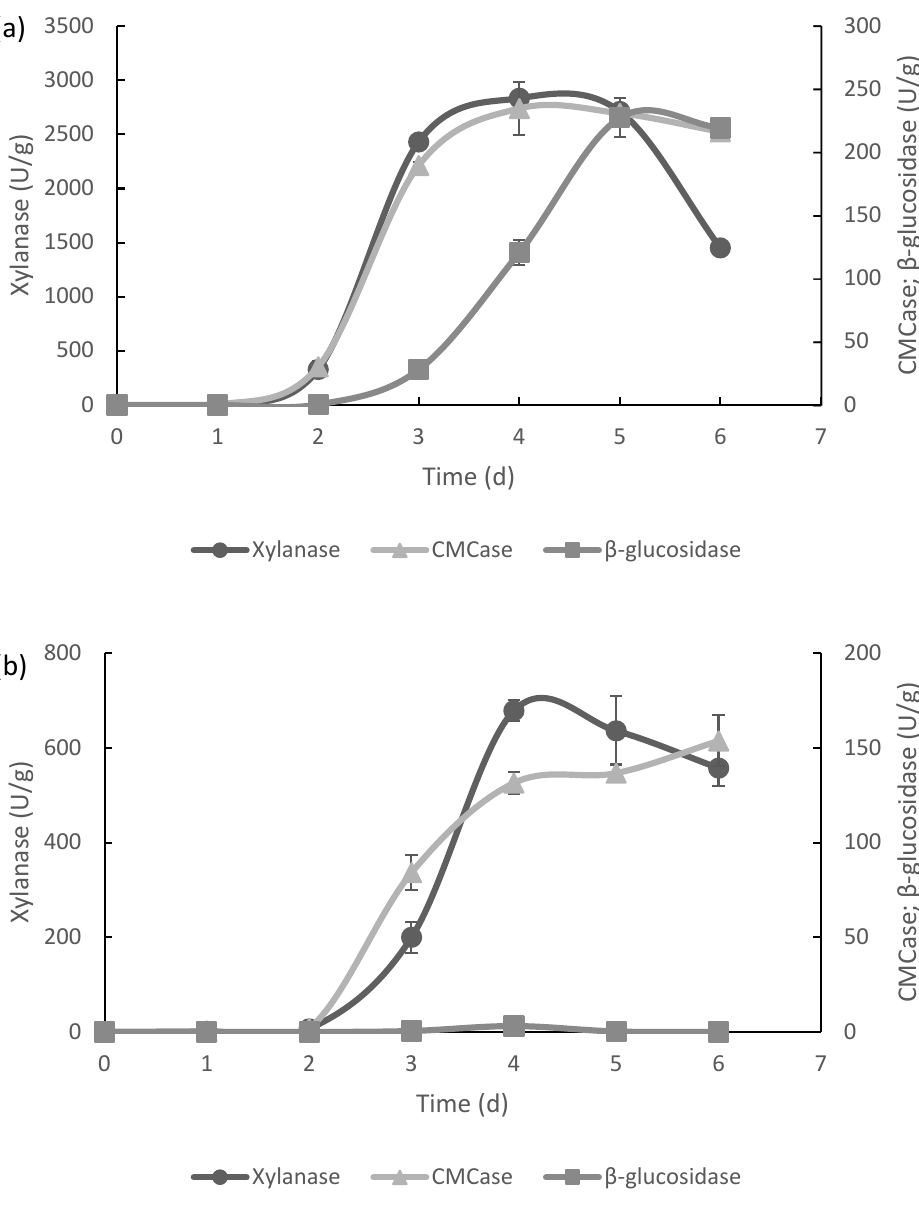
Figure 1. Time course of enzyme production by A. brasiliensis ( a ) and T. reesei ( b ) under solid ‐ state fermentation.